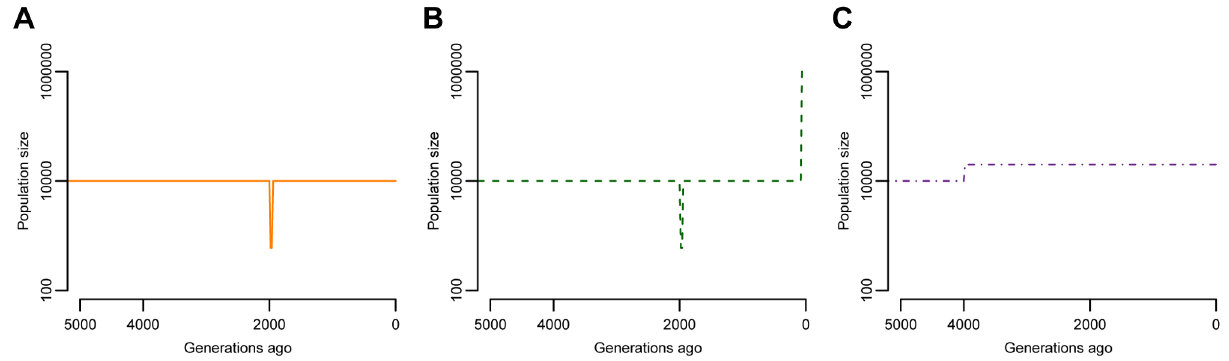
Figure 1. Models of population size changes over time. ( A ) A model of European population history with a severe bottleneck starting 2000 generations ago (BN). ( B ) A similar model of European population history as shown in ( A ), except that here the population instantaneously expanded 100-fold 80 generations ago (BN + growth). ( C ) A model with a 2-fold ancient expansion (Old growth). This is a possible model for African population